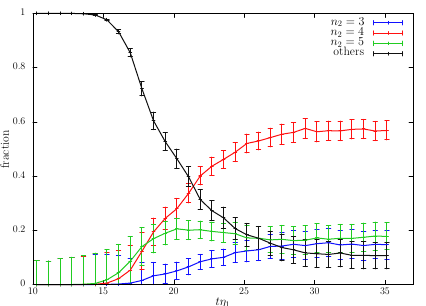
Figure 11 . The time-evolution of the fractions of the strings, R n